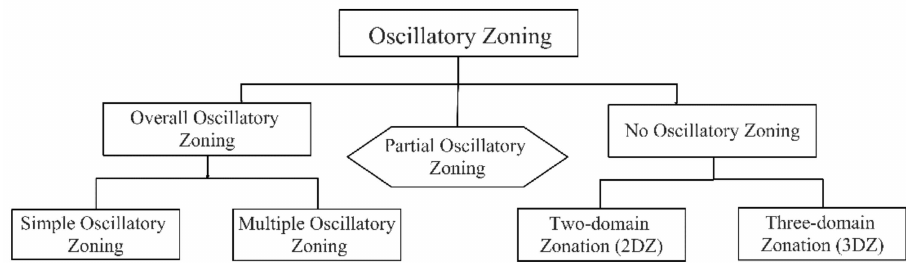
Figure 3. Flow chart representing types of oscillatory zoning.